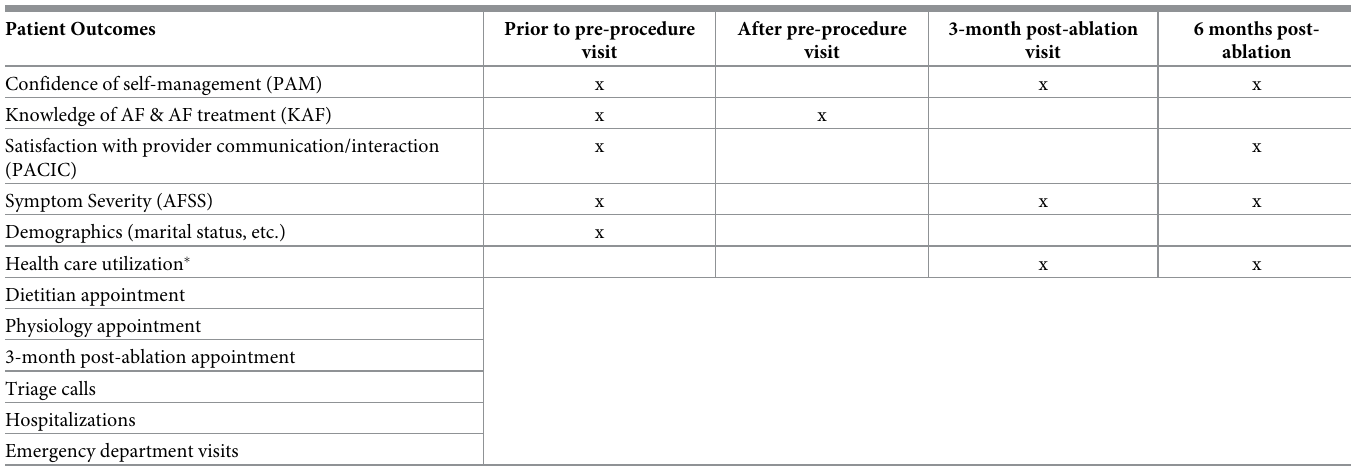
Table 2. Data collection schedule of patient